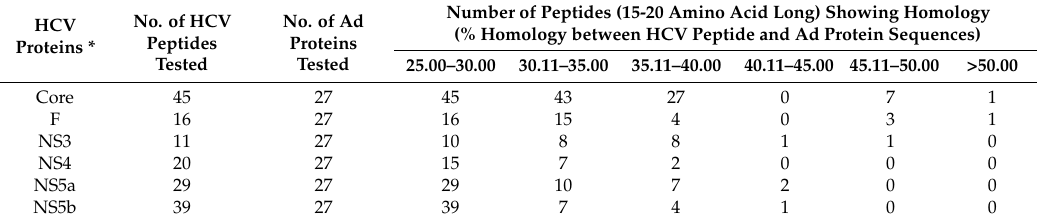
Table 1. Peptides derived from various HCV proteins contain amino acid sequence homology with Ad proteins.